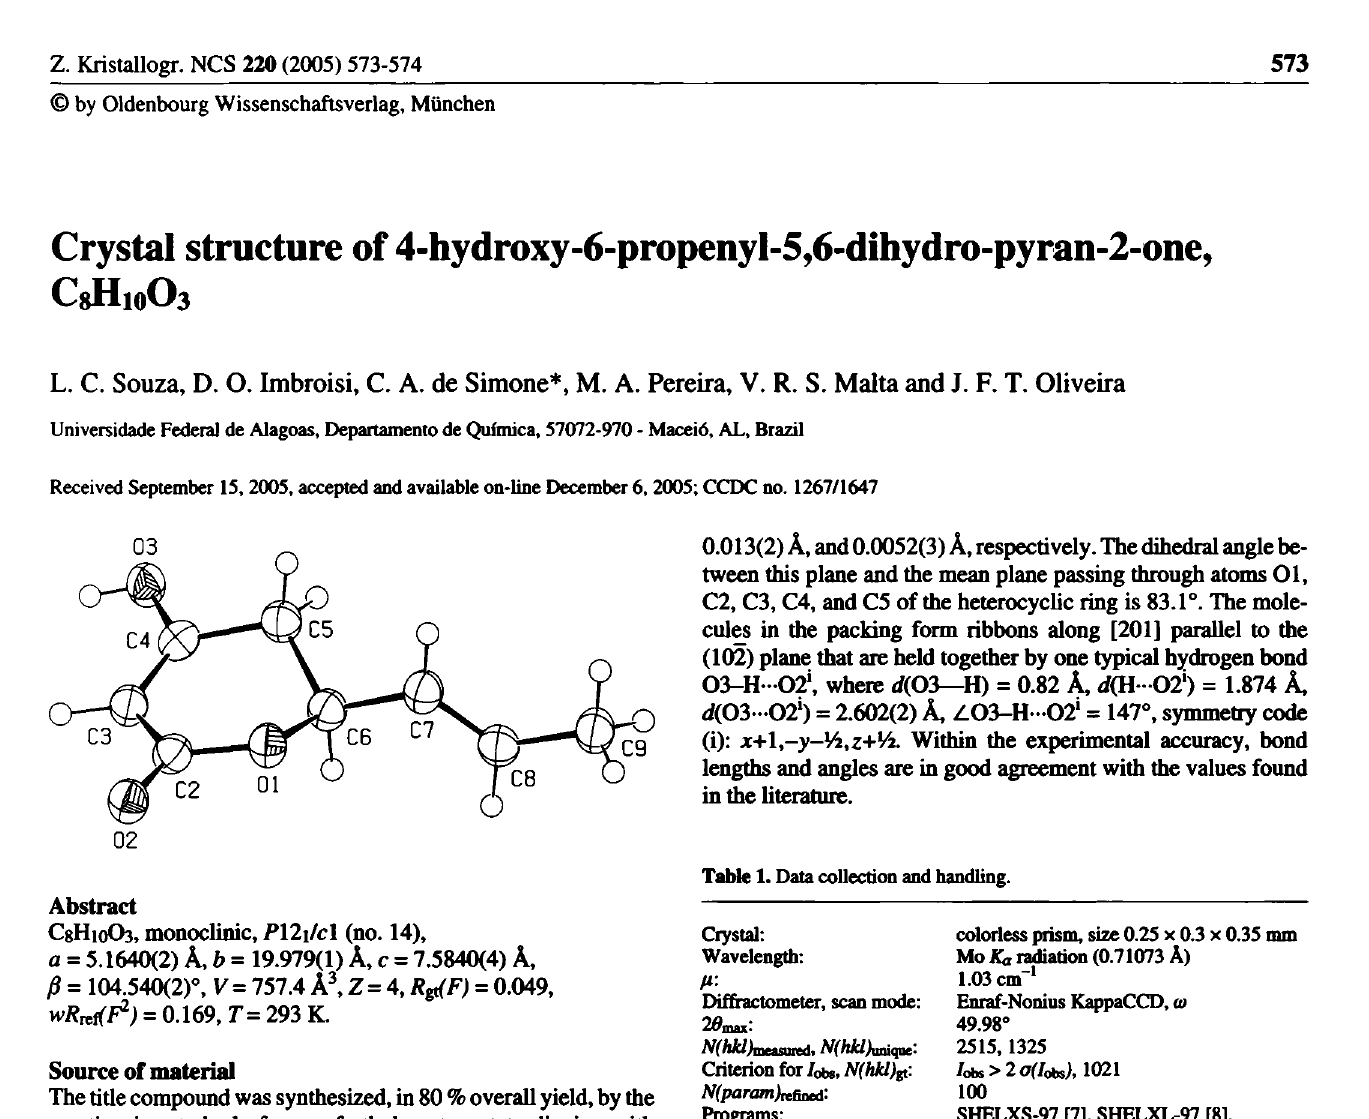
Table 2. Atomic coordinates and displacement parameters (in A 2 ).